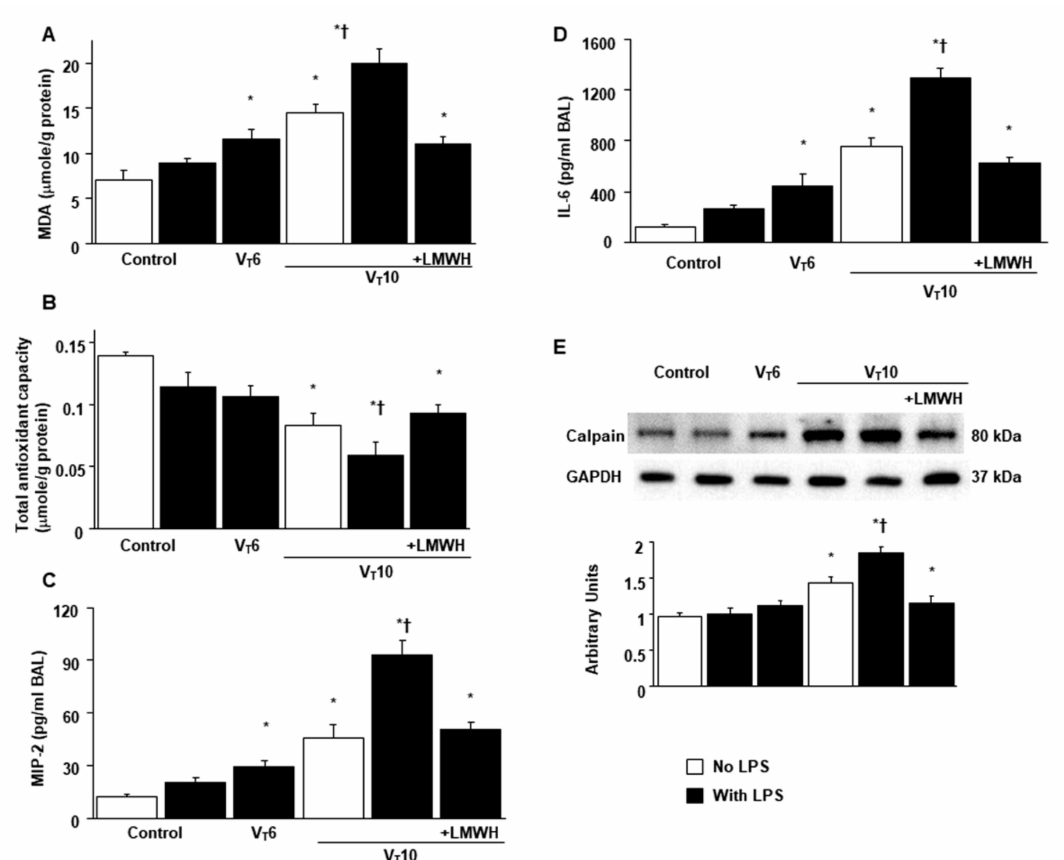
Figure 2. Inhibition of endotoxin-aggravated mechanical ventilation-enhanced oxidative stress, inflammatory cytokines production, and calpain expression by enoxaparin. ( A ) MDA (diaphragm), ( B ) total antioxidant capacity (diaphragm), ( C ) BAL fluid MIP-2, and ( D ) BAL fluid IL-6 were from the non-ventilated control mice and mice ventilated at a tidal volume of 6 mL/kg or 10 mL/kg for 8 h with or without LPS administration (n = 5 per group). Western blots were performed using antibodies that recognize calpain ( E ) and GAPDH expression from the diaphragms of non-ventilated control mice and mice ventilated at a tidal volume of 6 mL/kg or 10 mL/kg for 8 h with or without LPS administration (n = 5 per group). Arbitrary units were expressed as relative calpain activation (n = 5 per group). Enoxaparin, 4 mg/kg, was given subcutaneously 30 min before mechanical ventilation. * p < 0.05 versus the non-ventilated control mice with LPS treatment; † p < 0.05 versus all other groups. BAL = bronchoalveolar lavage; GAPDH = glyceraldehydes-phosphate dehydrogenase; IL = interleukin; MIP-2 = macrophage inflammatory protein-2; MDA =